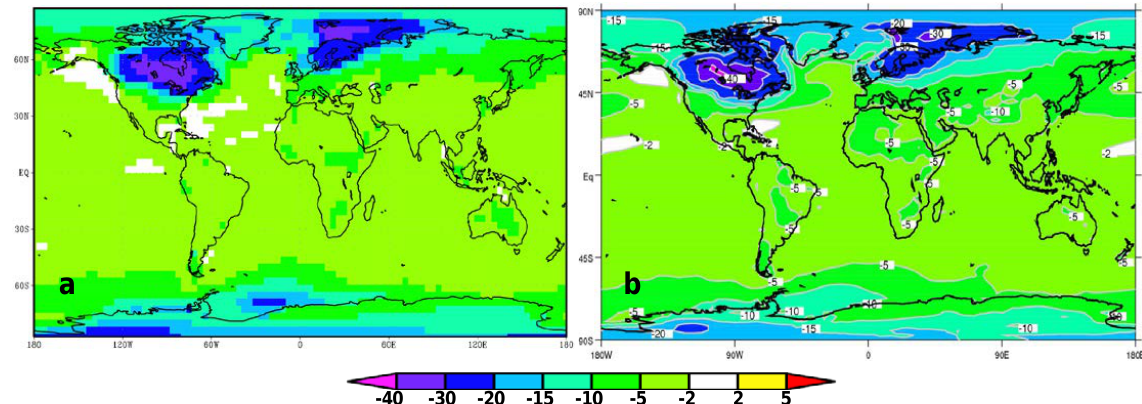
Fig. 2. Differences in annual mean 2m air temperature (in K) between simulations of the climate of the Last Glacial Maximum and of pre-industrial climate. (a) Difference between the LGM and the CTL simulation, (b) difference of the ensemble mean of the atmosphere- ocean-vegetation model simulations of PMIP-2 (Braconnot et al., 2007); (b) is taken from http://pmip2.lsce.ipsl.fr